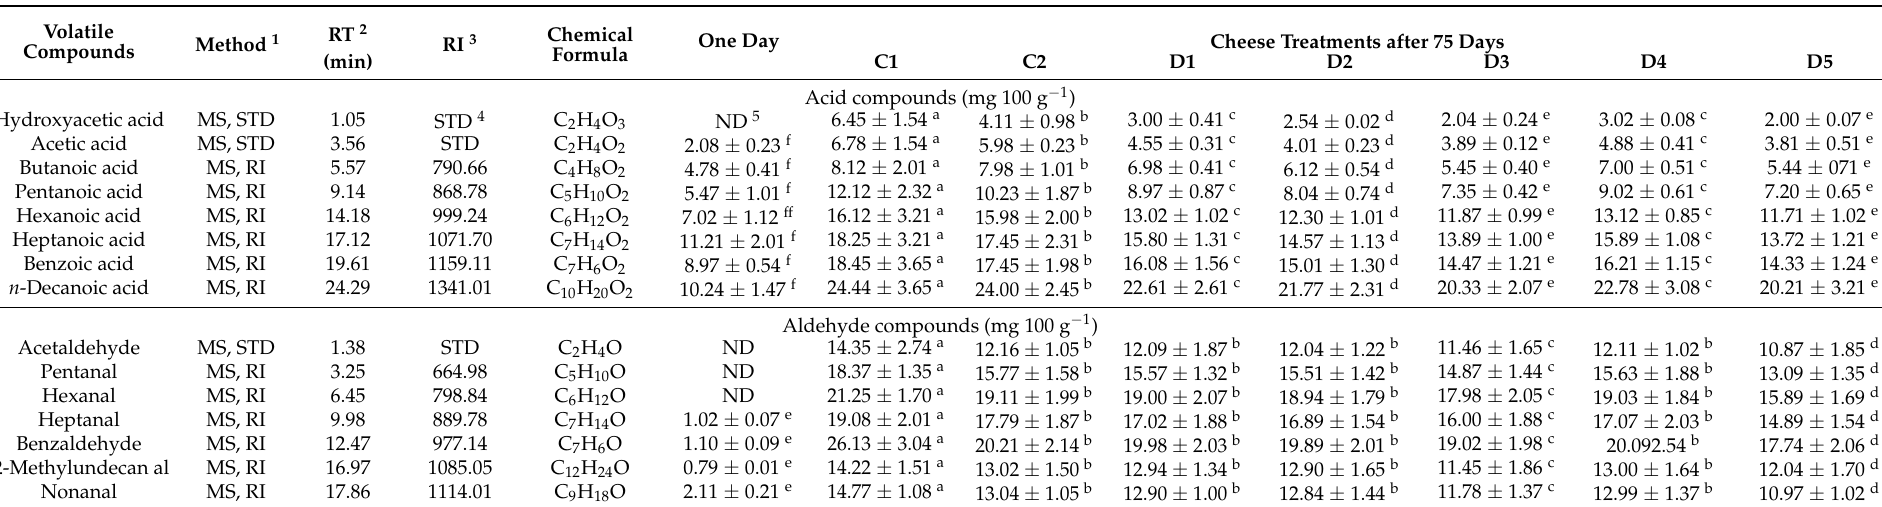
Table 3. Volatile acid and aldehyde compounds identified in cheese packaged under modified atmospheres (means ±